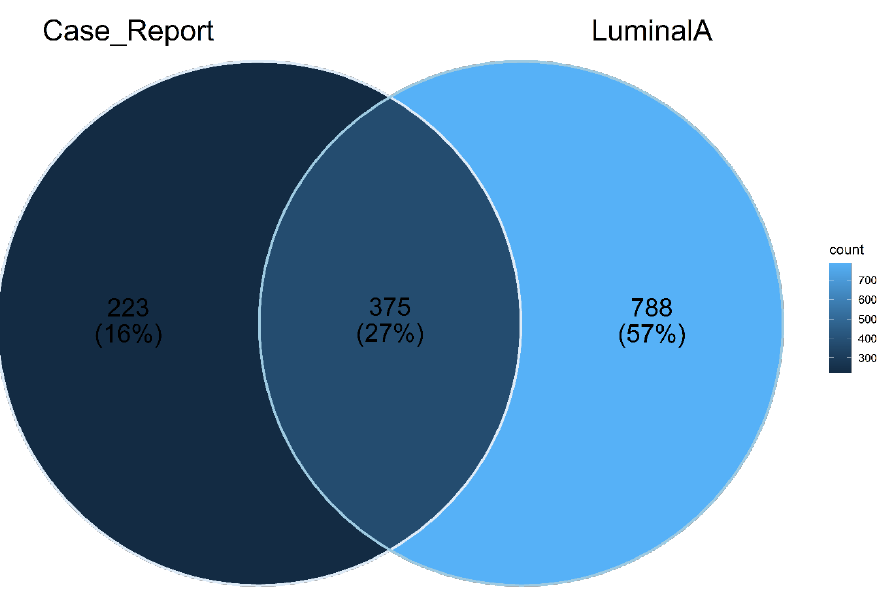
Figure 6. Genes with expression in common between reports of breast angiosarcoma and Luminal A subtype of breast cancer. Table 4. Genes with inverted expression (logFC) between the case of angiosarcoma and a case of Luminal A-breast cancer. The results indicate how the same genes over-expressed in an angiosarcoma case are under-expressed in lumina A breast cancer.